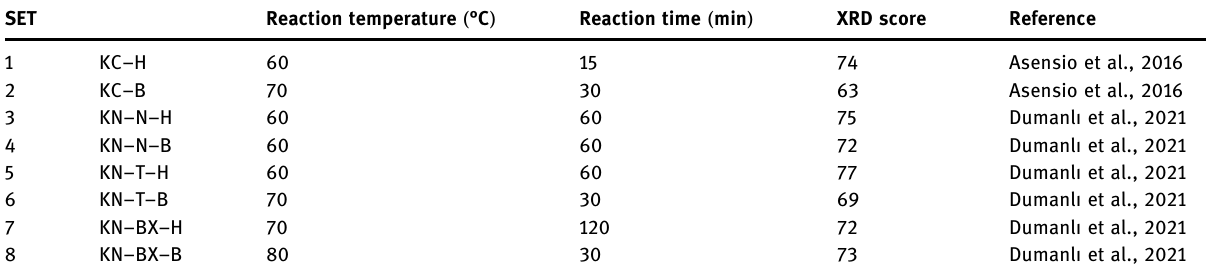
Table 2: Santite minerals ’ highest XRD scores, with respect to reaction temperature and time, given in the literature